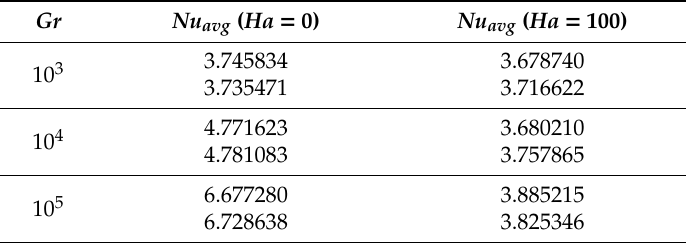
Table 2. Average Nusselt numbers at the hot wall for characteristic Grashof and Hartmann numbers obtained by the present method (underlined) and